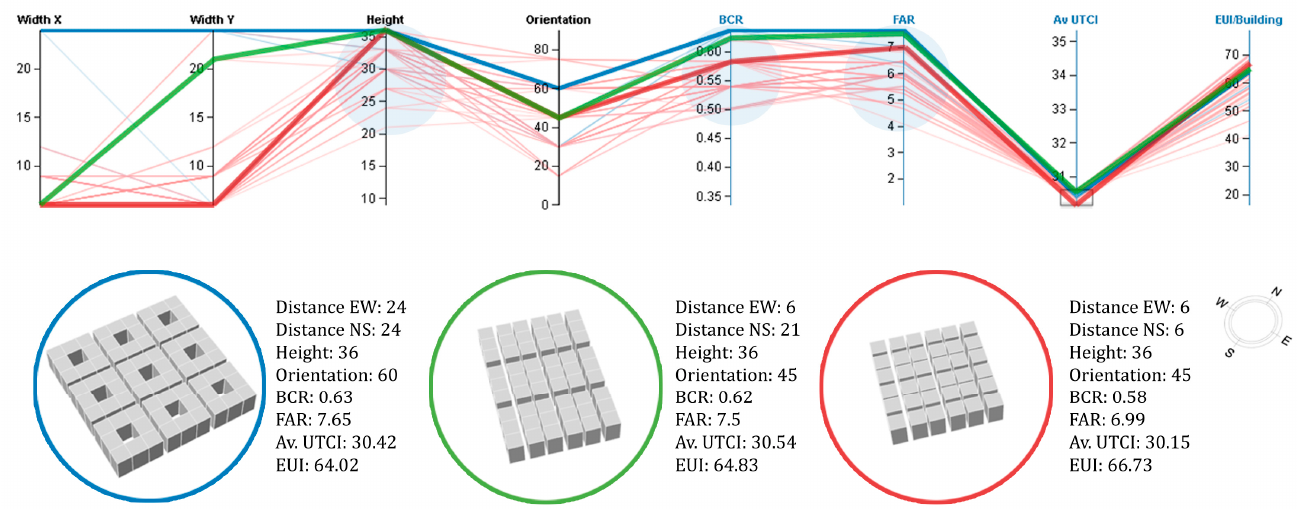
Figure 10. Parallel coordinates showing the selective cases for the minimum Av.UTCI.